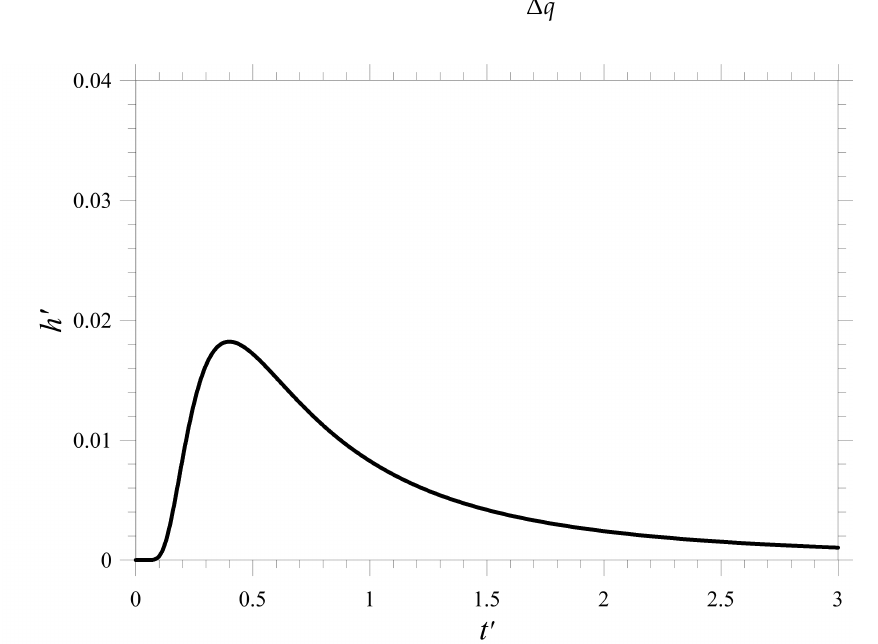
Figure 6. Heat pulse h (cid:48) produced by the seismic source as a function of time t (cid:48) (nondimensional